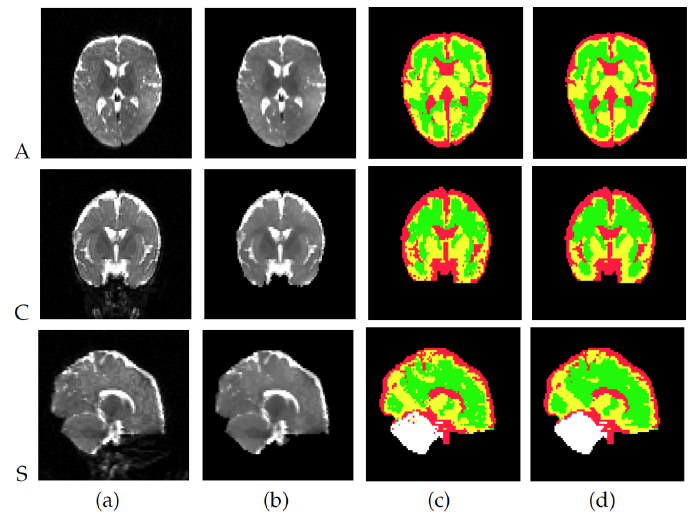
Figure 6. Visualization of the segmentation results of our proposed technique. The segmentation is performed in 3D and the results are projected here onto 2D axial (A), coronal (C), and sagittal (S) planes for visualization. Column ( a ) shows the original b0 scan images, ( b ) b0 scans after preprocessing and brain extraction using the proposed method, ( c ) initial segmentation using an NMF-based visual appearance model and adaptive shape model, and ( d ) results of final segmentation. CSF, GM, WM, and other brain tissues are displayed in red, yellow, green, and white,